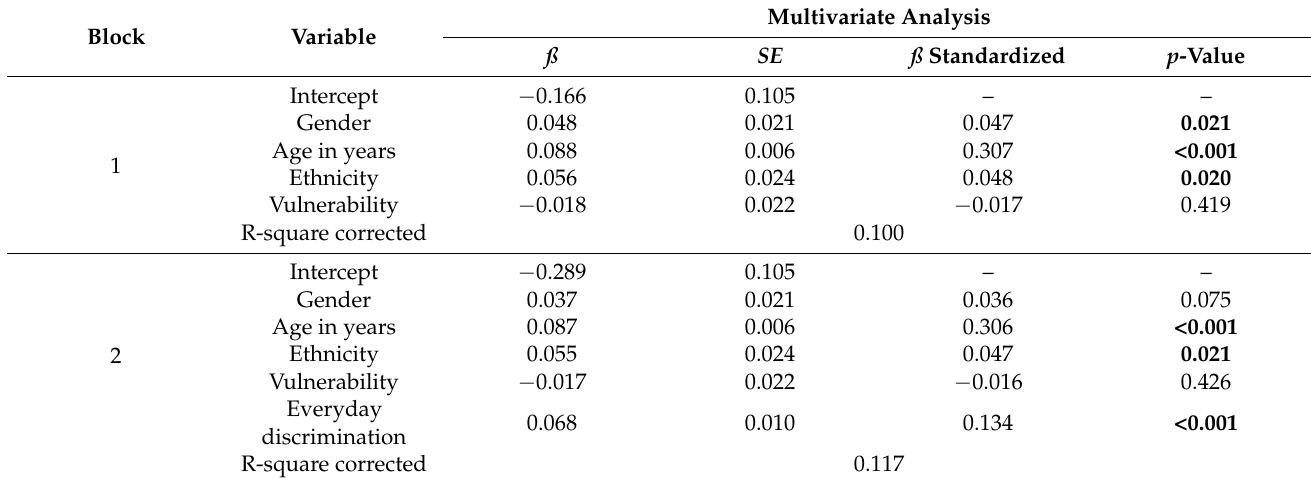
Table 3. Factors associated with substance